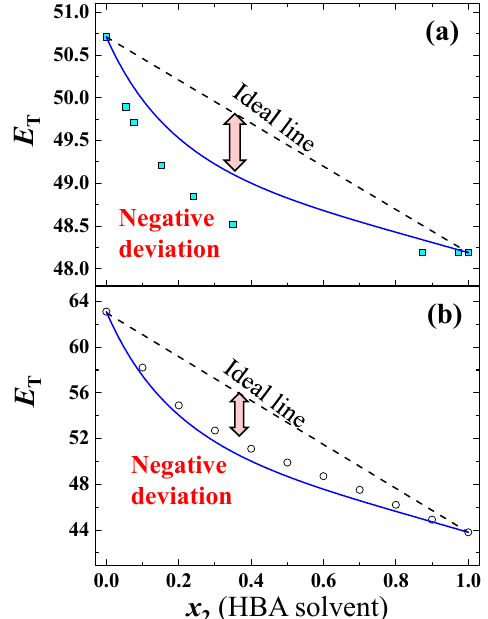
Figure 1. Comparison in electronic transition ( E T , kcal · mol − 1 ) for ( a ) nonpolar-polar systems of carbon tetrachloride (1)—dimethylformamide (2) and ( b ) aqueous systems of water (1)—dimethylformamide (2) as a function of mole composition of component 2 ( x 2 ) at 25 ◦ C. Black dashed lines show calculations from the ideal model (Equation (1)). Blue solid lines show predictions with the predictive model (Equation (2)) without considering hydrogen bond donor (HBD) contribution factor ( CF HBD = 1). The E T values in part ( a ) were collected from the phenol blue indicator [26]. The E T values in part ( b ) were obtained from the Reichardt indicator [15].